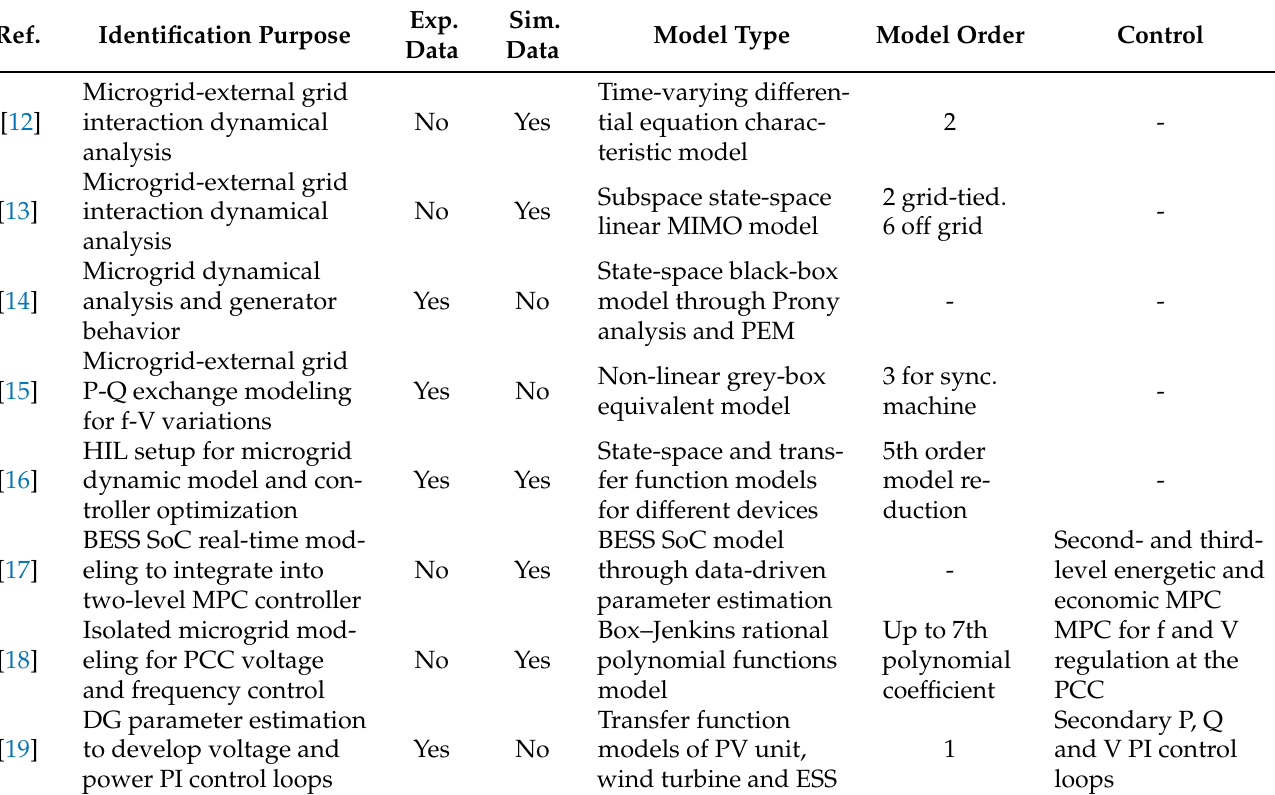
Table 1. Review of microgrid modeling